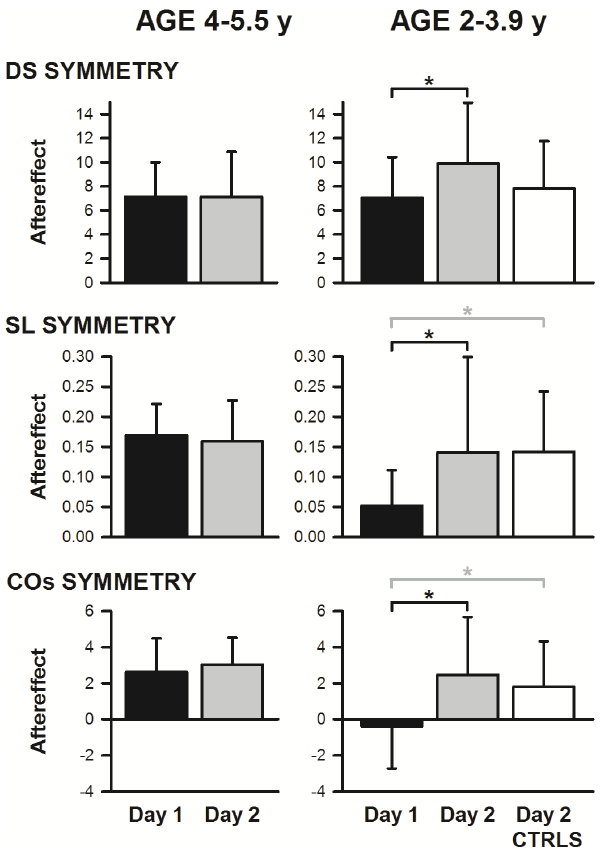
Figure 5. Size of aftereffect was age-dependent. Bars represent mean ( + 1 SD) aftereffect across children. In Experiment 1, younger children showed differences between Day 1 and Day 2, whereas older children did not (compare black and gray bars; pooled across perturbation type). Child controls of Experiment 2 (CTRLS; all , 4.0 y old) walked in the tied-belt condition at two speeds on Day 1, and experienced the abrupt perturbation on Day 2. Day 2 aftereffects for CTRLS (white bars) were comparable to Day 2 aftereffects for the younger children from Experiment 1 who experienced perturbations on both days, and were significantly greater than Day 1 aftereffects for these same children for SL and COs symmetry (asterisks). DS – double support; SL – step length; COs – centre of oscillation.